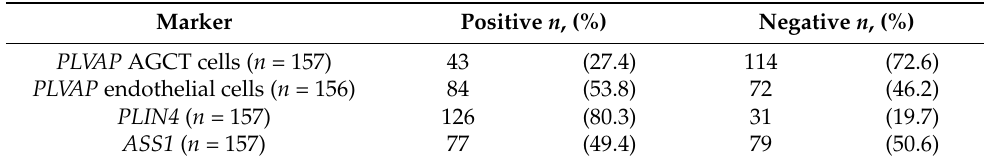
Table 3. Distribution of normalized PLVAP , PLIN4 , and ASS1 RNA in situ hybridization scores in AGCT